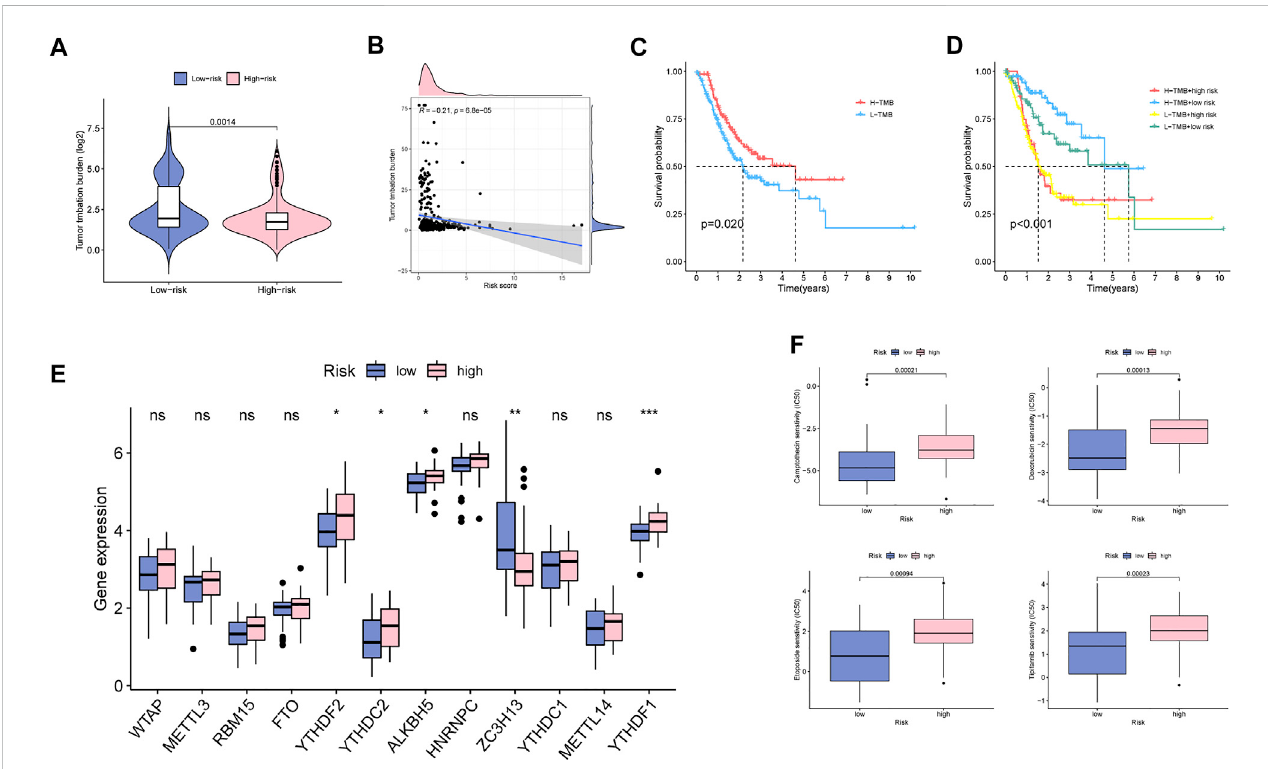
FIGURE 8 ClinicalpotencyanalysisofMBS. (A – B) TherelationshipbetweenTMBandMBRSS.Survivalanalysisofdifferentgroups (C) withTMBand (D) withTMBand risk score. (E) The relationship between m6A regulators and MBRSS (ns > 0.05, * p < 0.05, ** p < 0.01, *** p < 0.001). (F) Drug sensitivity analysis of